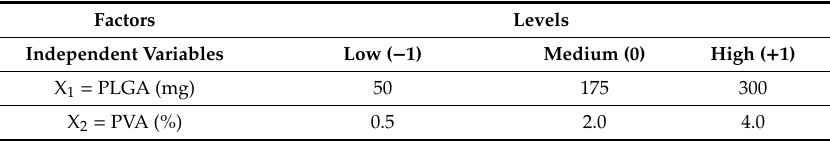
Table 1. Variables in “Design Expert” software for the preparation and optimization of catechin hydrate (CH) PLGA–nanoparticles (NPs). PVA, polyvinyl alcohol; PDI, polydispersity index. Factors Levels Independent Variables Low ( − 1) Medium (0) High ( +